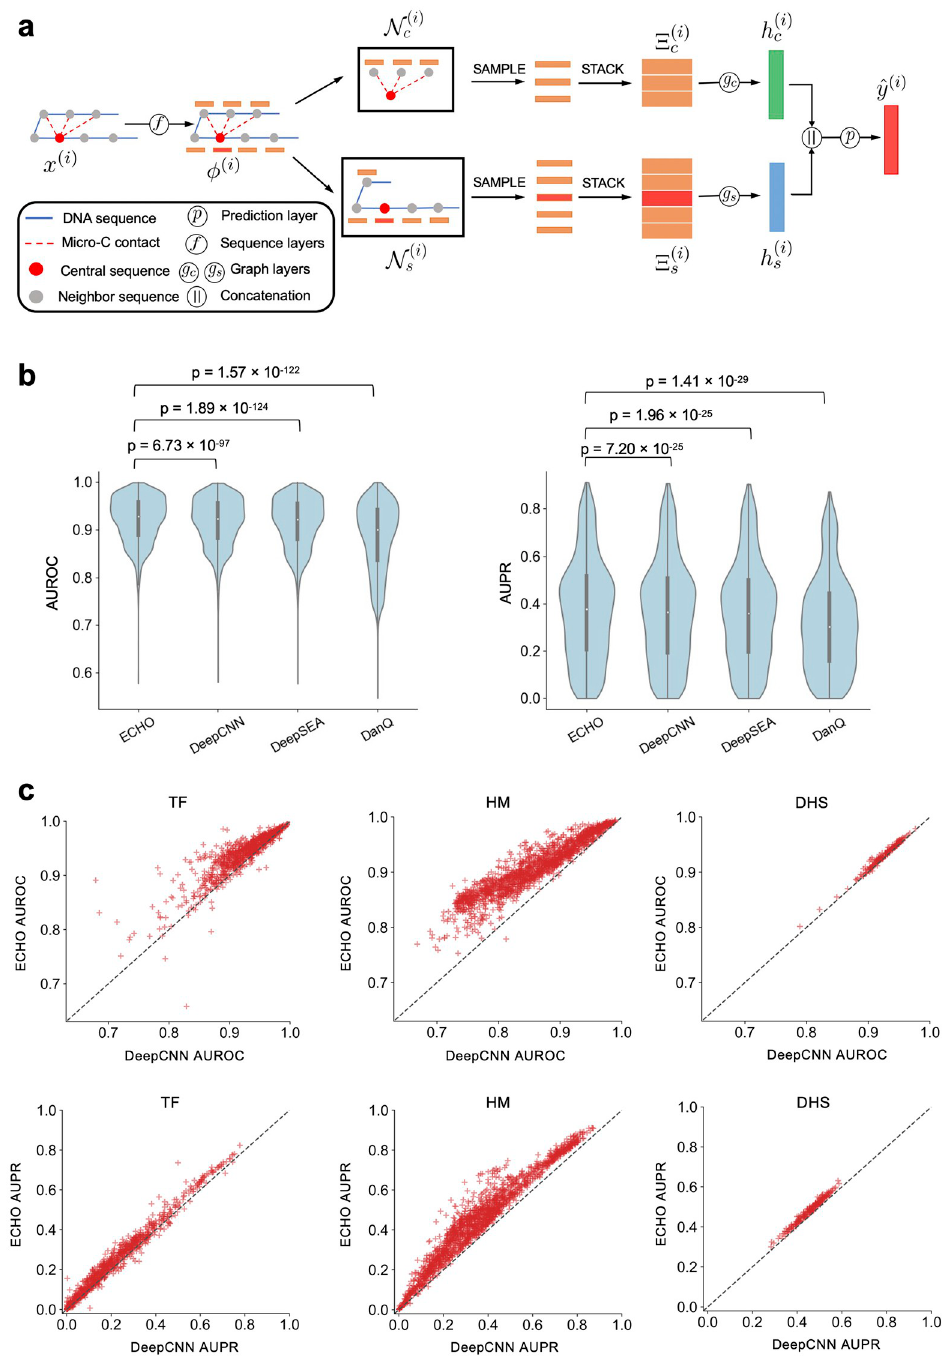
Fig 1. Architectural details of ECHO and its empirical performance in chromatin feature prediction tasks. (a) Model architecture. The model inputs are one-hot representations of DNA sequences. The inputs x are first fed into sequence layers f to extract hidden representations ϕ . For central sequence i , we first sample a fixed number of sequential neighbor sequences from its sequential neighbor set N ð i Þ and a fixed number of spatial neighbor sequences c from the spatial neighbor set N ð i Þ . The hidden representations of sampled sequential neighbors are stacked into a s feature matrix X ð i Þ which is input to graph layers g to learn an updated hidden representation h ð i Þ . The feature matrix c c c X ð i Þ stacked by spatial neighbors is fed into g s to learn an updated hidden representation h ð i Þ . A feature embedding s s concatenated by the two hidden representations will be fed into the final prediction layer p to compute a